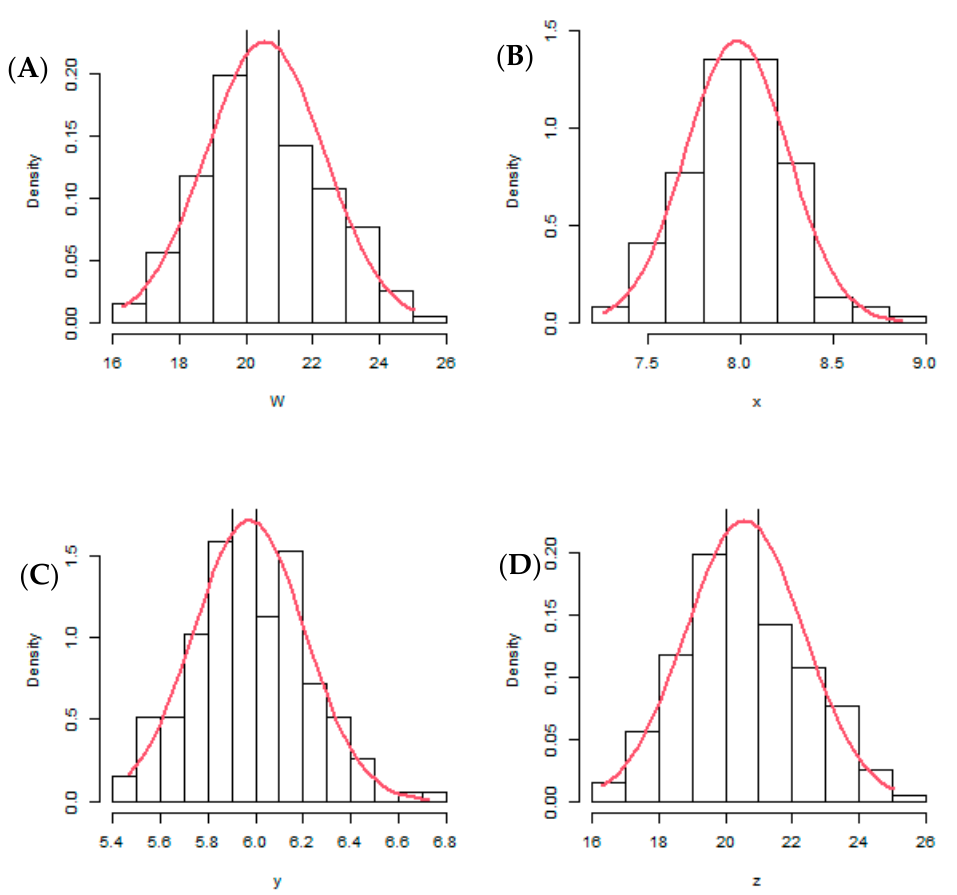
Figure 1. Distribution of seed size traits of 196 accessions of African yam bean evaluated during the 2018 and 2019 cropping seasons at three locations in Nigeria: ( A ) hundred seeds weight (g), ( B ) seed length (mm), ( C ) seed thickness (mm), and ( D ) seed width (mm).